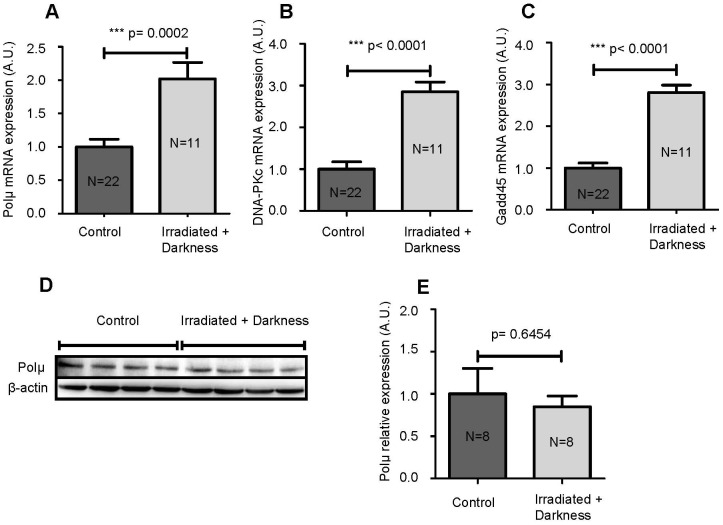
Effects of the combination of space radiation and darkness.Polµ (A), DNA-PKc (B) and Gadd45 (C) mRNAs were quantified by qPCR in larvae that developed in the dark and under the simulation of ISS radiation. Polµ proteins were quantified by western blotting (D). Each lane contains proteins from 3 larvae. Western blot results were analyzed and quantified by densitometry using a Fusion Fx7 imaging system (Vilber Lourmat, Marne-la-Vallée, France) and Polµ expression was normalized to β-actin (E). Results are expressed as the mean ± SEM. “A.U.” stands for “arbitrary units”.